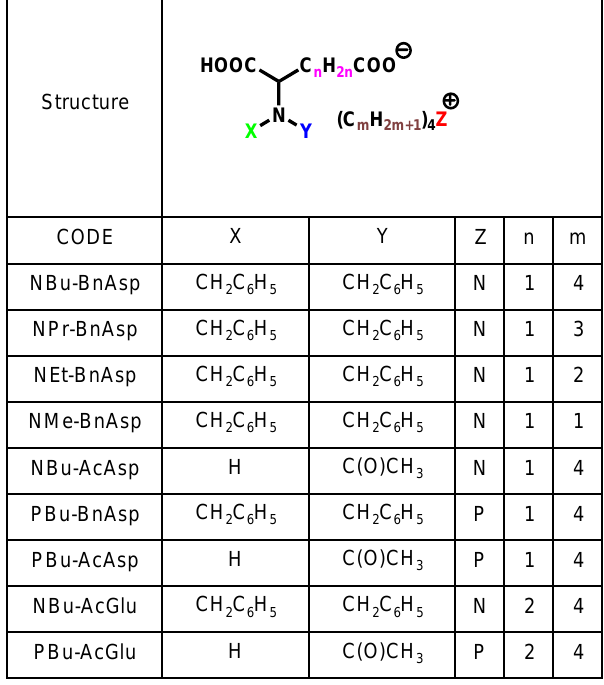
Table 4. Structure of amino acid derived additives for ionic liquids.